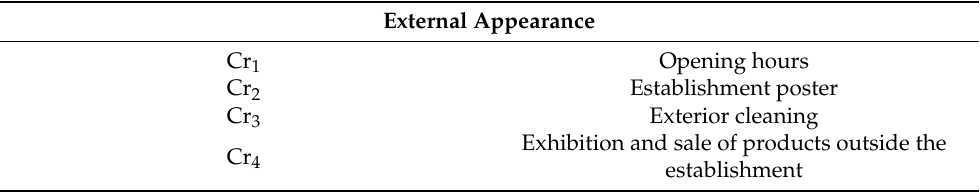
Table 3. External appearance.